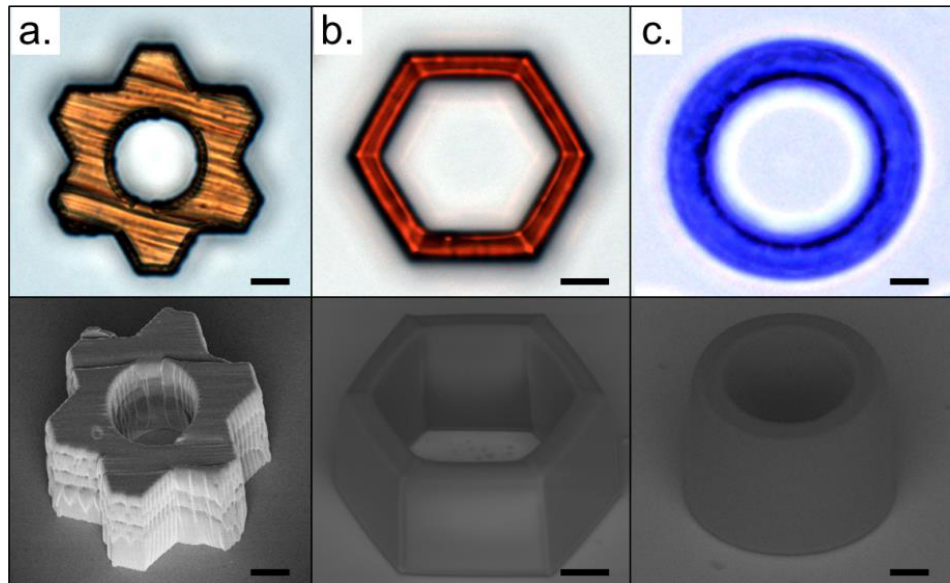
Figure 6. Optical microscopy ( top ) and SEM images ( bottom ) of 3D structures fabricated using azobenzene-based dyes as a photoinitiator in a concentration of 1.00 wt%: ( a ) Disperse Orange 3 (DO3), ( b ) Disperse Red 13 (DR13), and ( c ) Sudan Black B (SBB). The scale bar is 20 μm.